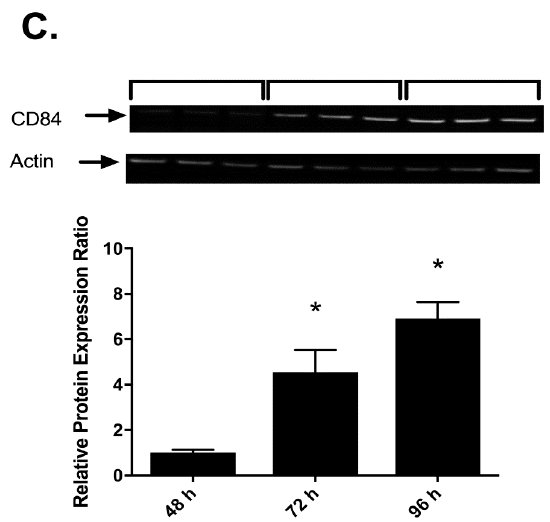
Figure 4. Effects of I3C, DIM and PMA on CD84. ( A ) I3C and DIM on CD84 protein in u-THP-1. THP-1 cells were treated with I3C (5 µM) or DIM (5 µM) for 96 h, cells were harvested for Western analysis and quantitation as described in Materials and Methods. Results expressed as mean ± SD ( n = 3); ( B ) Effects of PMA on CD84 protein levels. THP-1 cells were differentiated using PMA as described in Materials and Methods. After treatment, cells were harvested for protein and CD84 protein levels were determined by Western blot analysis. Results expressed as mean ± SD ( n = 3). * indicates significant difference from each other at p ≤ 0.05; ( C ) Time-dependent effects of PMA on CD84 protein in THP-1 cells. U-THP-1 cells were treated with PMA for 0–96 h and cells harvested at indicated time points for western analysis and quantitation as described in Materials and Methods. Results expressed as mean ± SD ( n = 3). * indicates significant difference from 48 h at p ≤ 0.05. However, differentiation appeared to significantly upregulate CD84 mRNA as well as protein levels (Figure 4B,C). PMA induction of u-THP-1 cells to d-THP-1 led to a two to four-fold increase in CD84 mRNA levels (Figure 4B) and significant induction of CD84 protein (Figure 4C). The PMA-induced increase in CD84 protein was time-dependent (Figure 4C). Interestingly, d-THP-1 appeared to express four-fold higher AHR mRNA and 85-fold higher CYP1B1 mRNA than u-THP-1 (Figure 5).